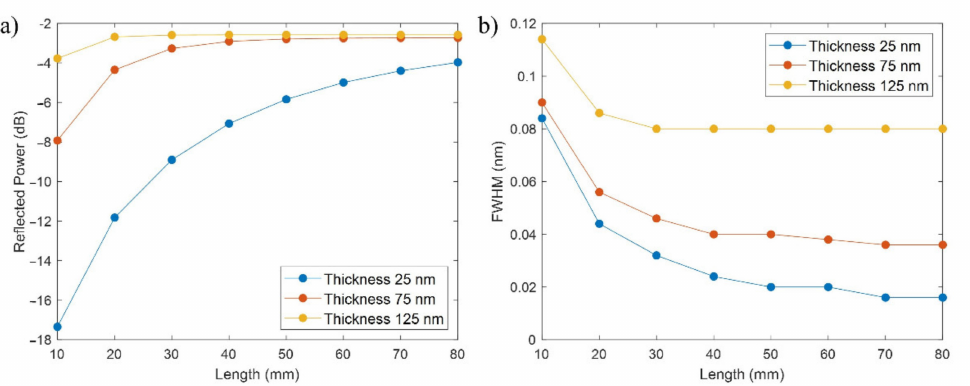
Figure 6. ( a ) FBG band reflected peak power (dB) vs. length (mm), and ( b ) FBG band FWHM (nm) vs. length (mm), for a neck of 0 µ m and several thin-film